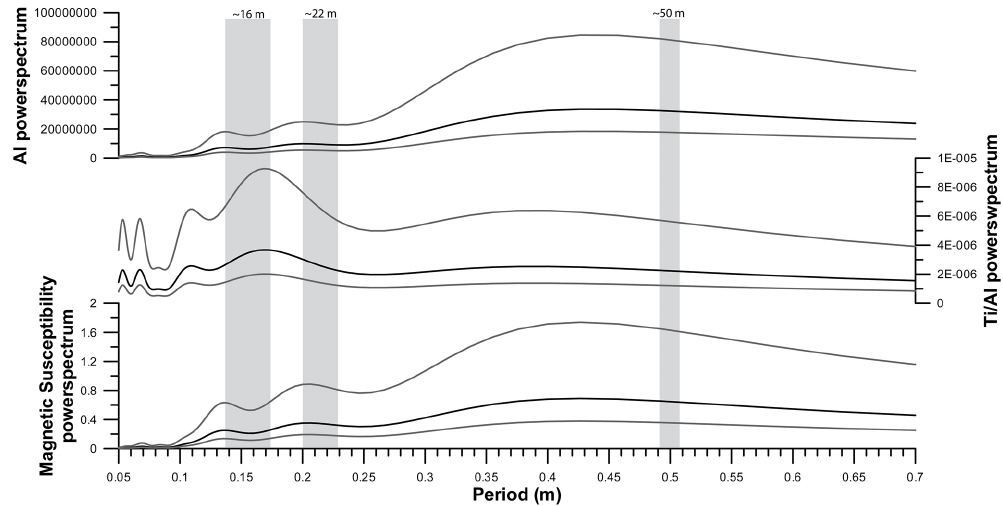
Figure 6. Blackman–Tukey power spectra of magnetic susceptibility, Ti / Al and Al with 90% confidence